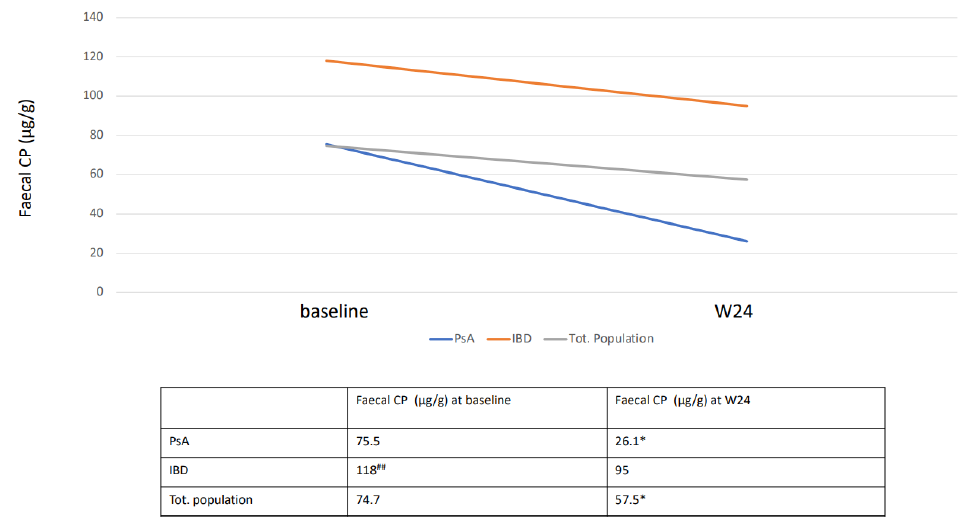
Figure 2. Mean baseline and W24 faecal CP levels stratified by co-morbidities. Data are displayed as mean. Statistical analysis was performed with Wilcoxon matched pairs test: * p < 0.05 with respect to baseline; Mann – Whitney test: ## p < 0.01 with respect to subjects with PsA. An analysis of faecal CP values stratified by therapy type was performed. No signif- icant reduction was assessed at W24 for any of the anti-IL17 drugs, whereas a significant reduction was detected for all anti-IL23 drugs ( p < 0.05) (Figure 3). At W24, a reduction in faecal CP values was also observed for patients on anti-TNF- , but no statistical analysis was performed for the low number of subjects (data not shown).